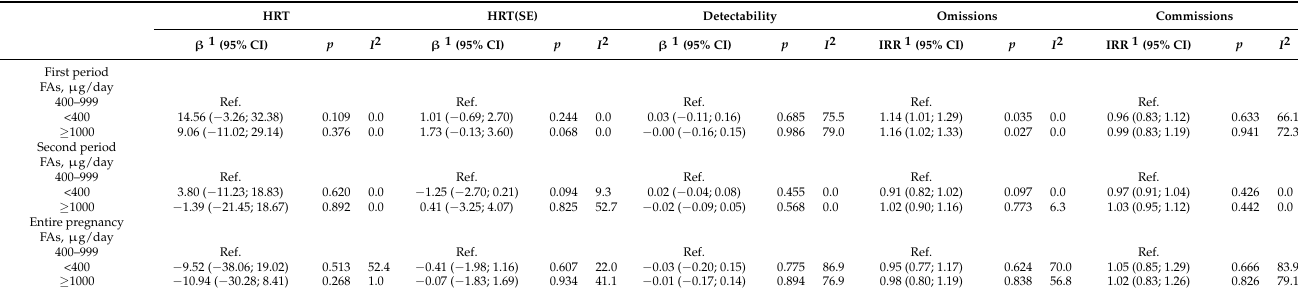
Table 2. Fully-adjusted combined association between folic acid supplement (FAs) use during pregnancy and attentional function outcomes in children aged 4–5 years of the Infancia y Medio Ambiente (INMA) cohort study, Spain, 2003–2008 ( n = 1329). HRT HRT(SE) Detectability Omissions Commissions